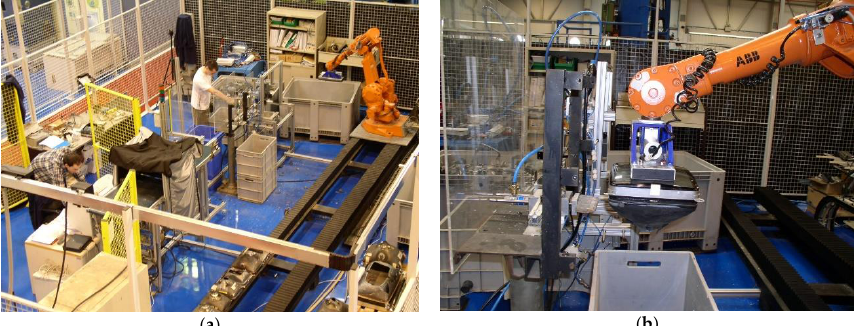
Figure 6. ( a ) Recycling line with robots and human operators; ( b ) robot performing dangerous tasks.